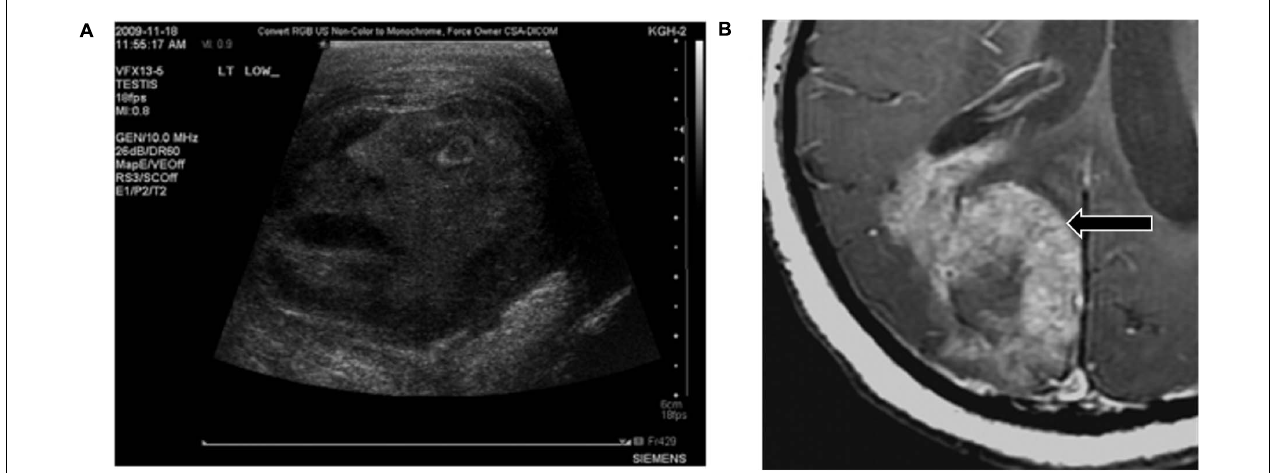
FIGURE 4 | Examples of pareidolia that neither assist with nor hinder diagnosis. (A) The scrotal ultrasound from a patient with a testicular condition appears to resemble the face of a man in pain. (B) This lethal glioblastoma resembles a rabbit. Reproduced from Roberts and Touma (2011) and Massoud and Kalnins (2016), respectively.